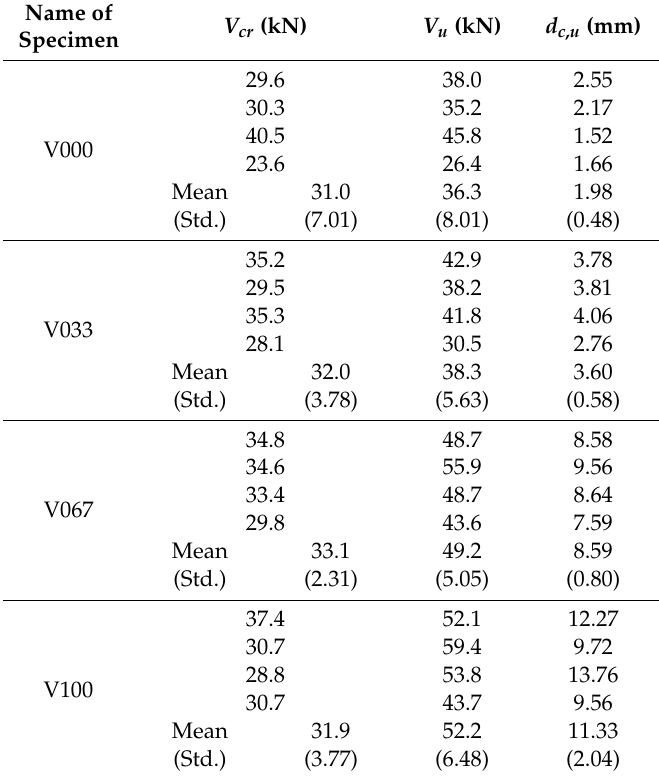
Table 3. Summary of the cracking and ultimate shear loads and the displacement at the ultimate load obtained from the shear tests of